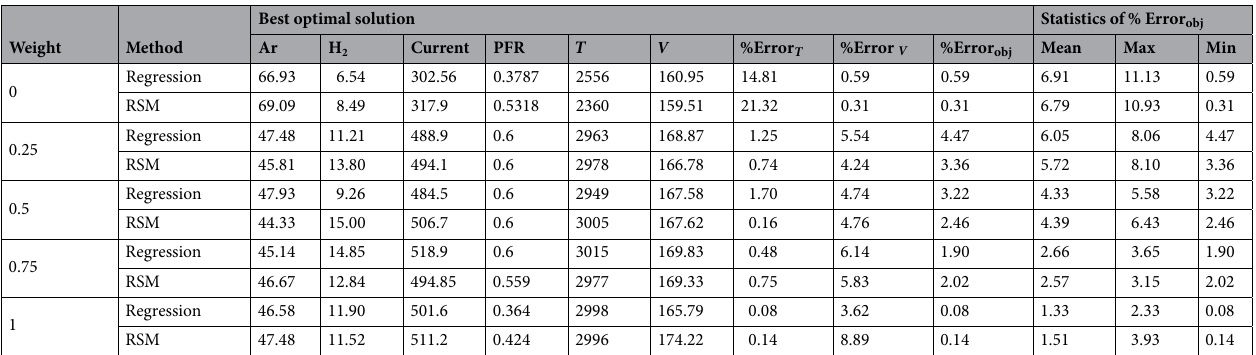
Table 5. For an assigned value of w and 100 initial estimates of the solution of Eq. (8), the solution with the least error in Eq. (8) and the corresponding errors in T and V .